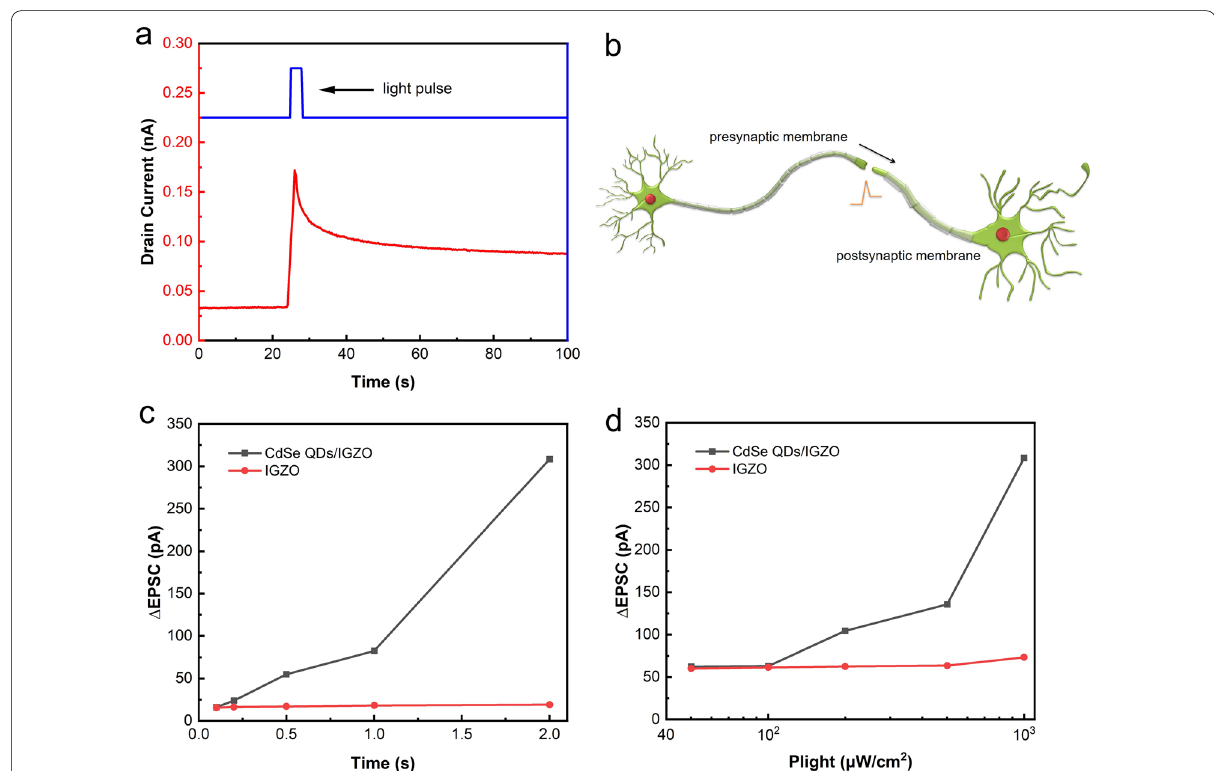
Fig. 3 a EPSC performance of the synaptic transistor stimulated by visible light pulse (532 nm, 1 mW/cm 2 , 2 s). b Schematic diagram of the signal transmission process between biological synapses. c and d The of EPSC gain as functions of incident light pulse width and light power intensity in hybrid channel transistor and IGZO